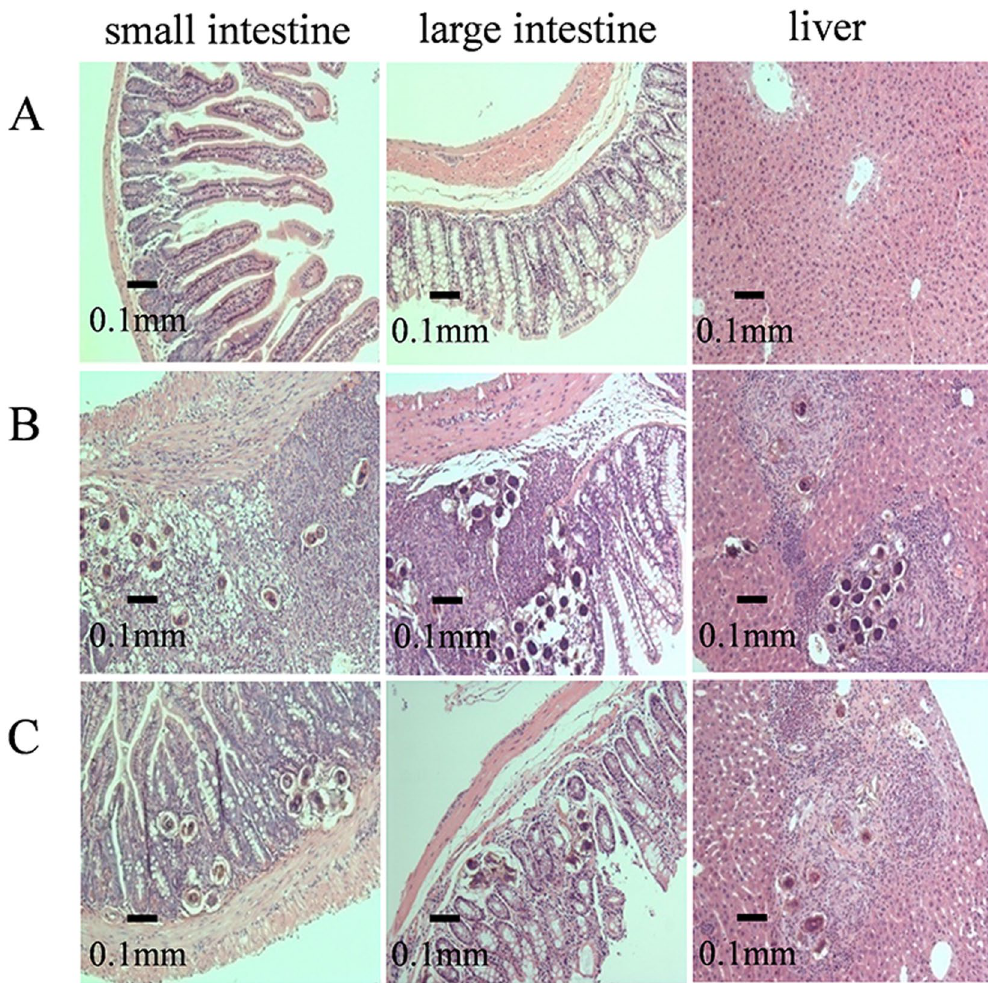
Figure 2. Histopathology examination of intestinal tissues and livers. The panel A was from control group, panels B and C were from single infection of S. japonicum and coinfection of S. japonicum and S. typhimurium